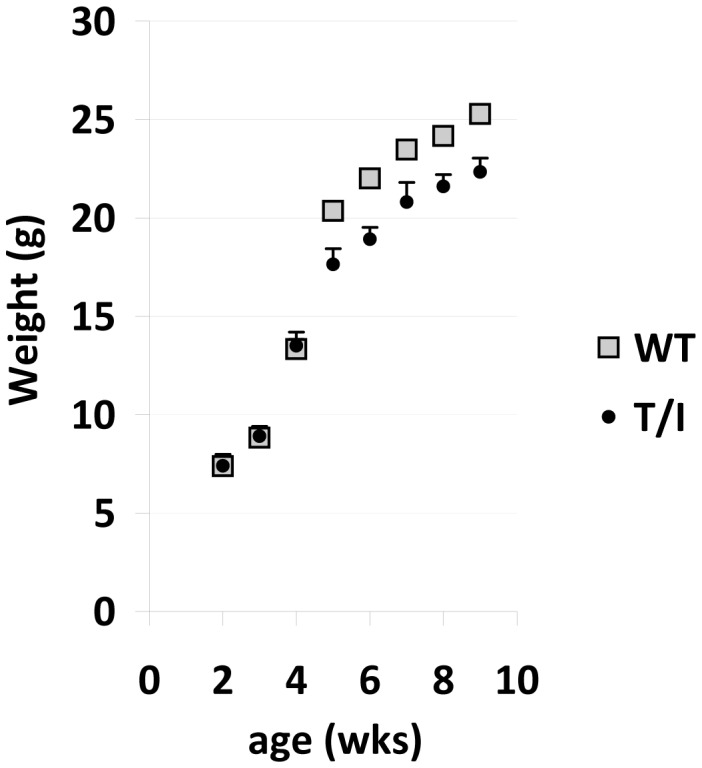
Body weights of T/I mice begin to lag soon after weaning.Mean ± SEM body weights are shown for wild type and T/I male mice between 2 and 9 wks of age. The number of litters and mice represented are 8 litters and 2–24 mice/point for wild type (WT) and 14 litters and 3–12 mice/point for T/I mice. Similar data was also obtained for the following strains that did not differ from wild type values at any of the 8 time points tested: Il10
−/− (IL10 KO), 5 litters, 3–21 mice/point; Tnf
−/− (TNF KO), 5 litters, 7–13 mice/point; T-het/I, 14 litters, 2–6 mice/point. The SEMs for WT mice ranged from 0.2 to 0.6 g and thus are hidden by the markers chosen. *indicates a significant difference between WT and T/I mice; p values ranged from 0.0001 to 0.03. Similar trends were seen in female mice (not shown).